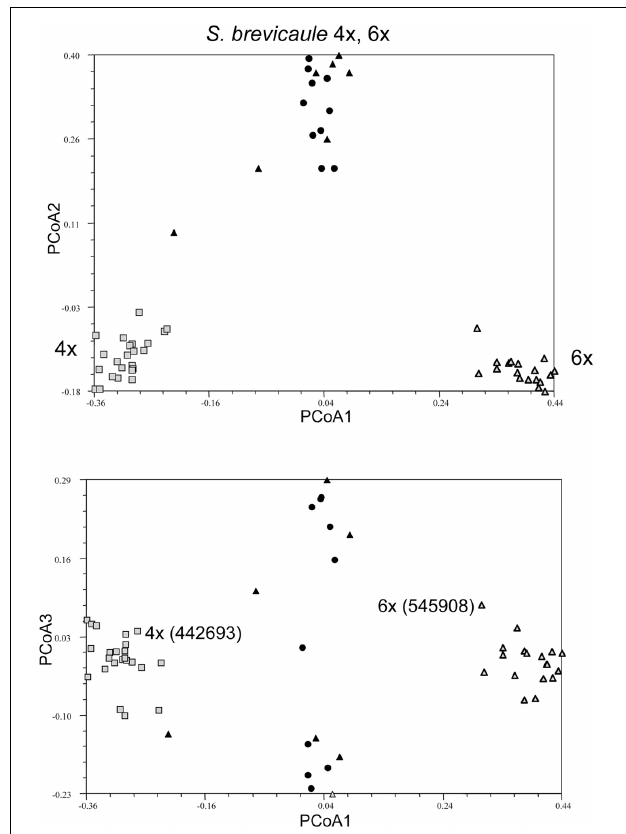
FIGURE 4 | Principal coordinate analysis showing clustering of individuals in single genebank accessions of probable self-incompatible species Solanum brevicaule 4x and 6x showing clustering of two accessions differing in ploidy relative to a broader species sample, represented by single individuals from several genebank accessions. The tetraploid accession members are denoted by gray shaded squares, hexaploid accession members are by gray shaded triangles, and the taxon members by black circles (4x) or triangles (6x) depending on ploidy.